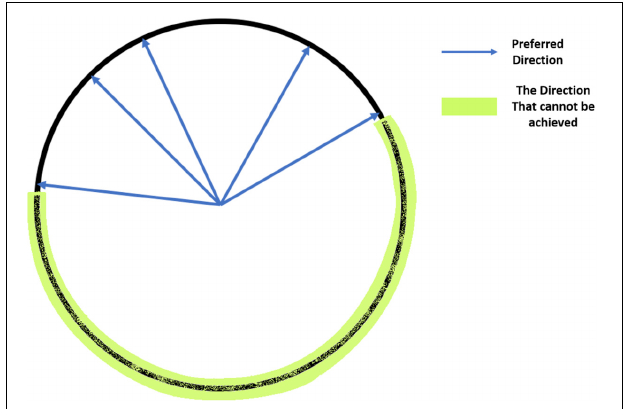
FIGURE 2 | Illustration of the coverage of the full range of HDs: If all the preferred direction vectors cover only half of the possible HDs, then the vectors in the other half circle cannot be achieved by a non-negative weighted linear combination of these vectors, so the predicted angles will not cover all values between 0 ◦ and 360 ◦